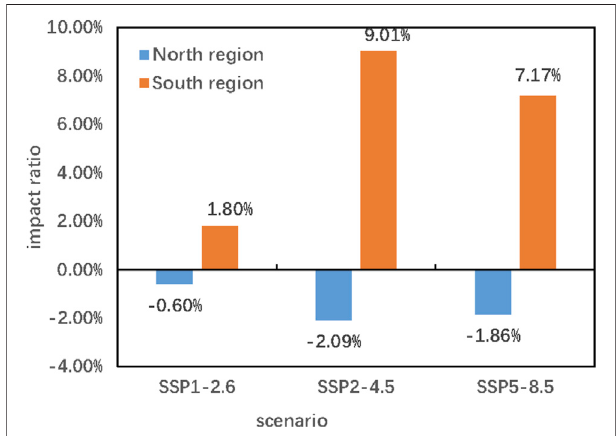
FIGURE 8 | The impact ratio of climate change in the main grain- producing areas from 2021 to 2035.